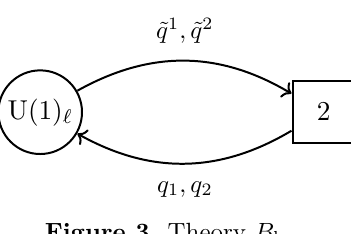
Figure 3 . Theory B loc